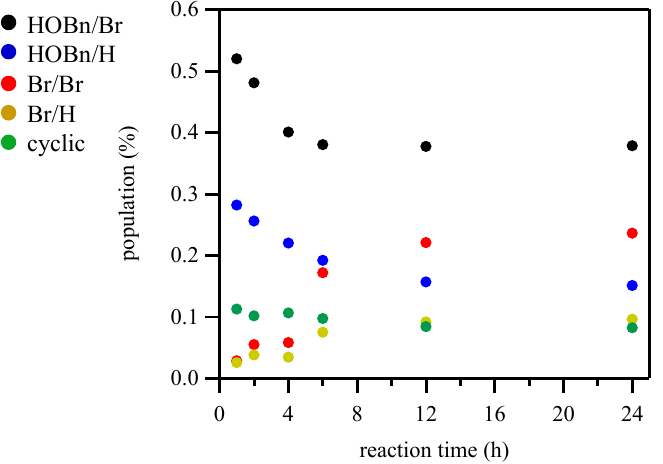
Figure 4. SEC traces of crude aliquot collected from the polymerization mixture of M1 at selected times.